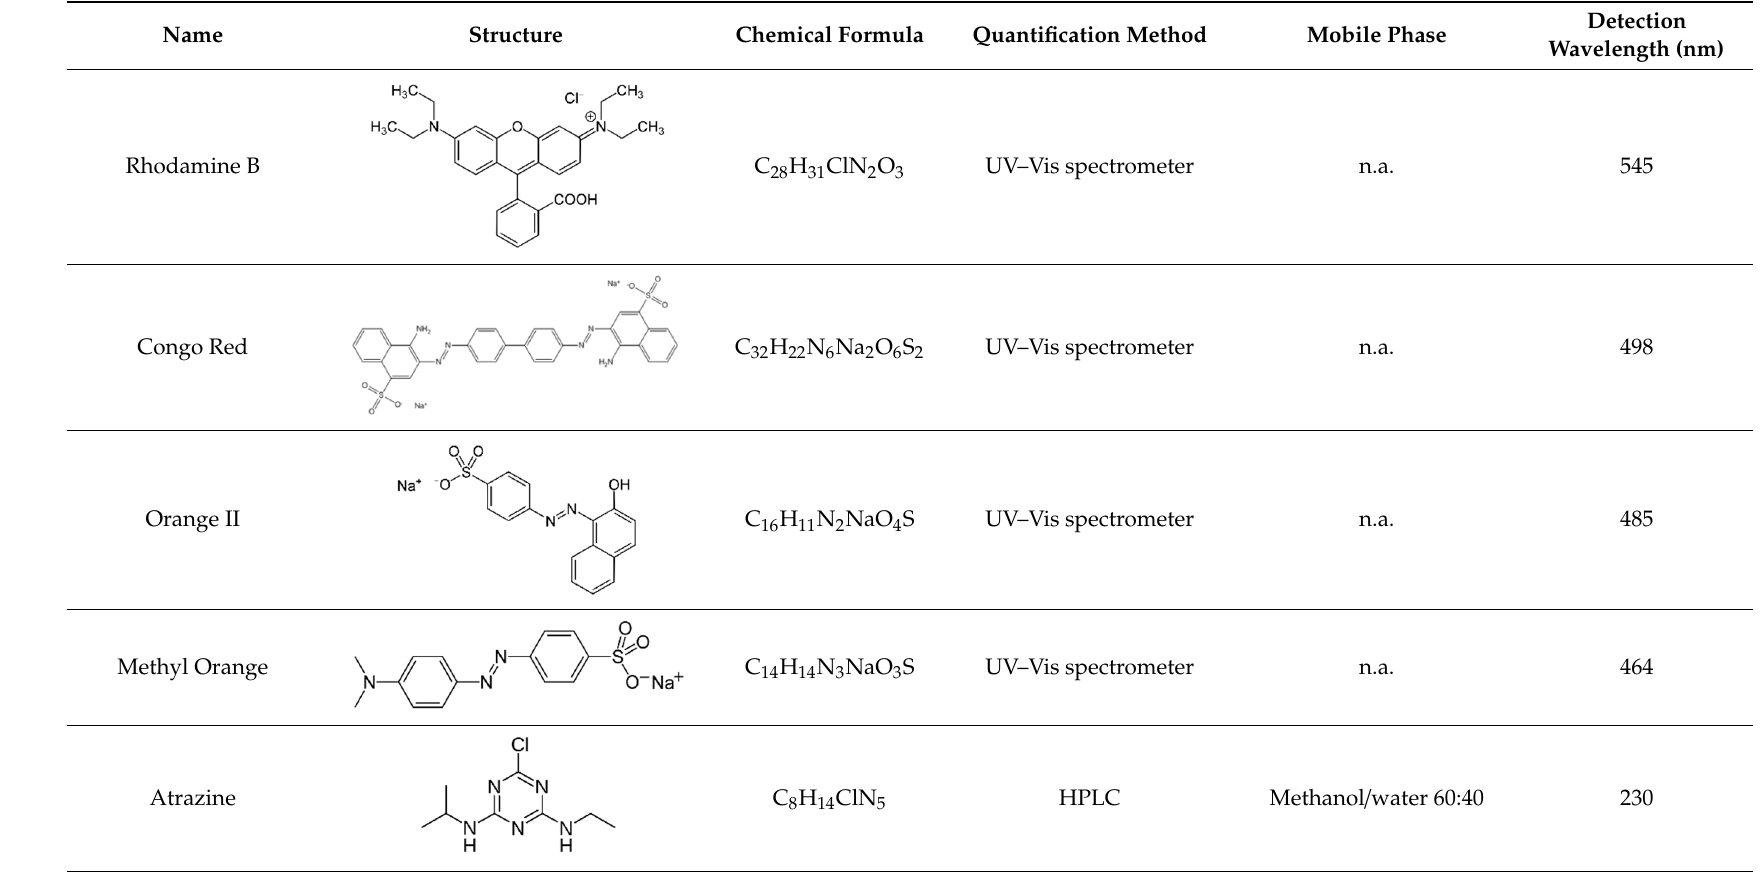
Table 1. Quantification methods for selected organic compounds.